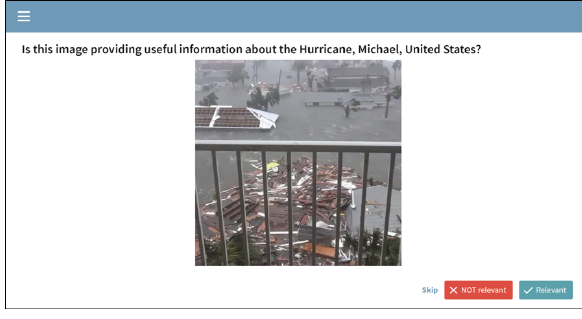
Figure 3. Crowd4EMS Relevance